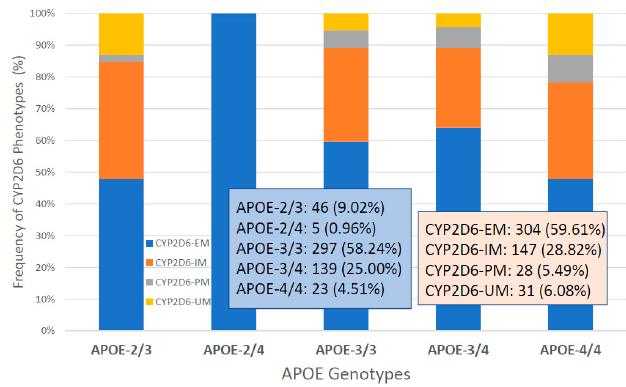
Figure 19. Distribution and frequency of CYP2D6 extensive (EM), intermediate (IM), poor (PM) and ultra-rapid metabolizers (UM) associated with APOE genotypes.